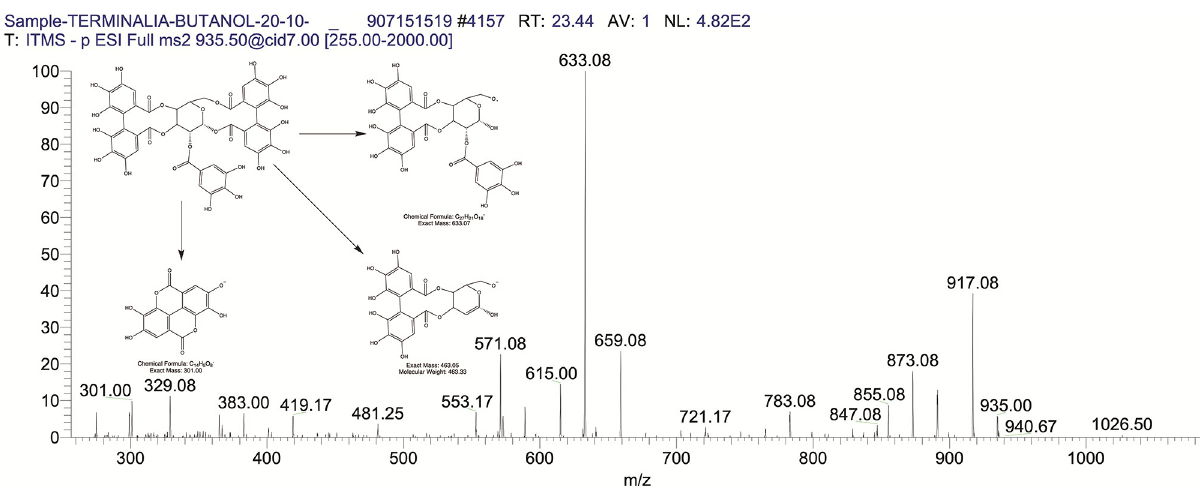
Fig 7. The mass spectrum of galloyl-bis HHDP hexoside and its fragmentation pattern.